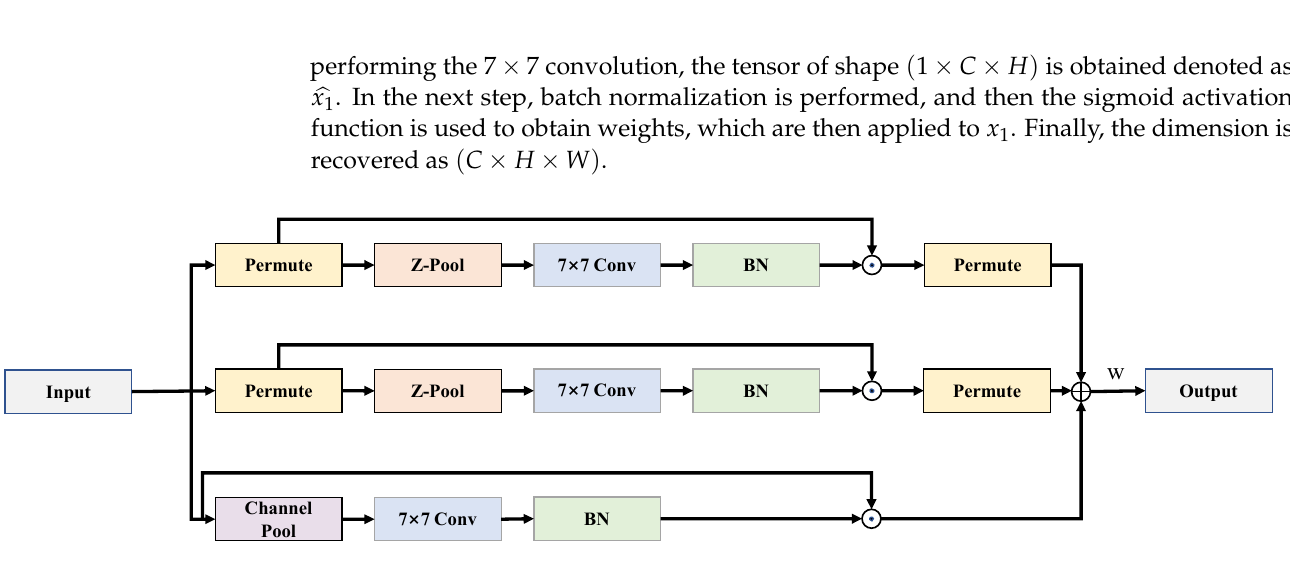
Figure 3. Architecture of improved triplet